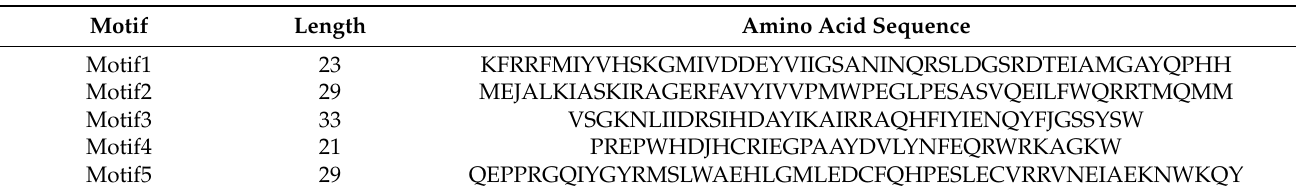
Figure 4. Conserved motif ( A ) and gene structure ( B ) analysis of StPLD genes. Different motifs are indicated by different colors. Yellow color bars represent the exon, lines represent the intron, while purple color bars indicate the untranslated region (UTR) both at 5 ′ and 3 ′ ends. Table 2. List of the conserved motifs of StPLD proteins.